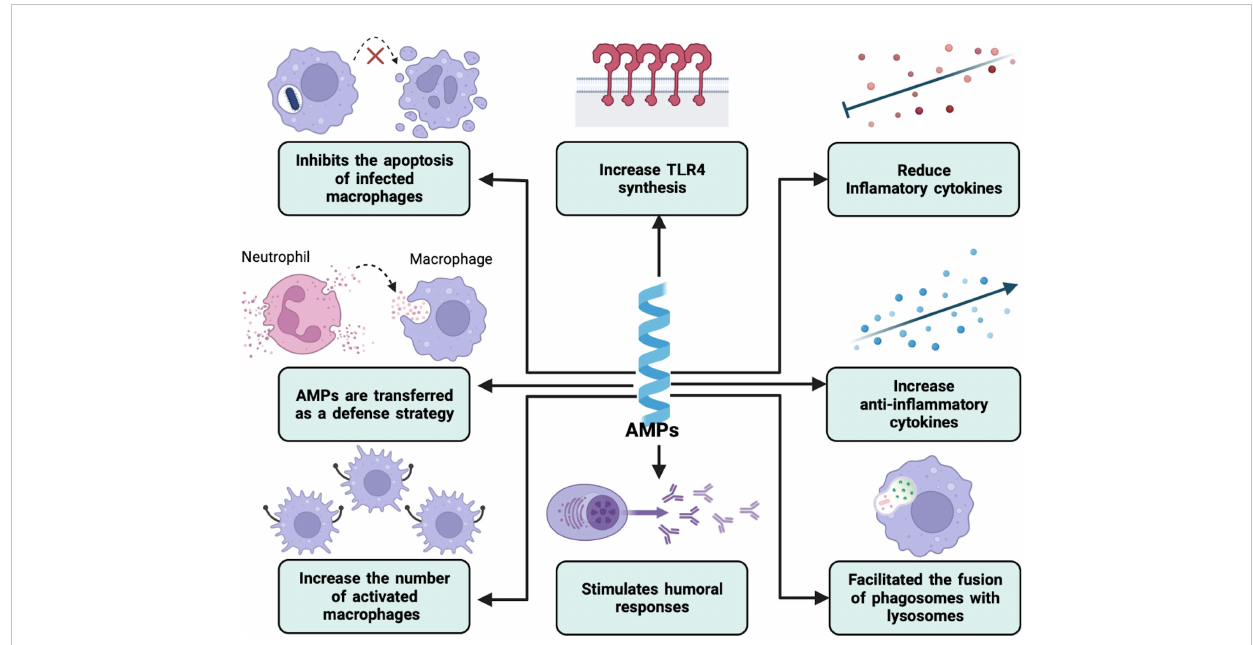
FIGURE 2 Immunomodulation by AMPs in intracellular bacterial infections. AMPs can modulate the host immune response in different ways. These include the regulation of the secretion of both anti- and proin fl ammatory cytokines and the expression of certain innate immune receptors. They can also increase the number of active macrophages and facilitate the phagolysosome formation. On the other hand, humoral immunity can also be modi fi